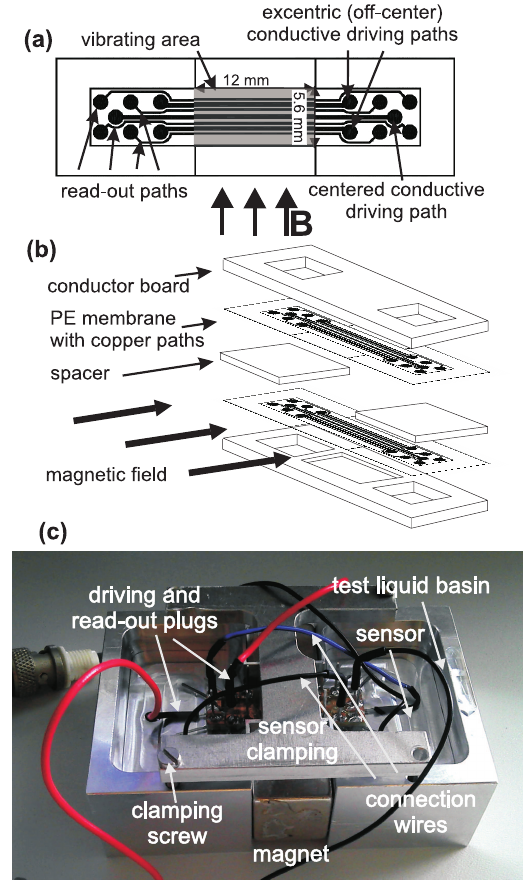
Figure 2. In (a) , the design of the PE membrane and the arrange- Figure 2. In (a), the design of the PE membrane and the arrangement of the excitation and read-out paths are shown. (b) shows the assembly ment of the excitation and read-out paths are shown. (b) shows the of the double membrane sensor and (c) depicts the measurement set–up. assembly of the double membrane sensor and (c) depicts the mea- surement